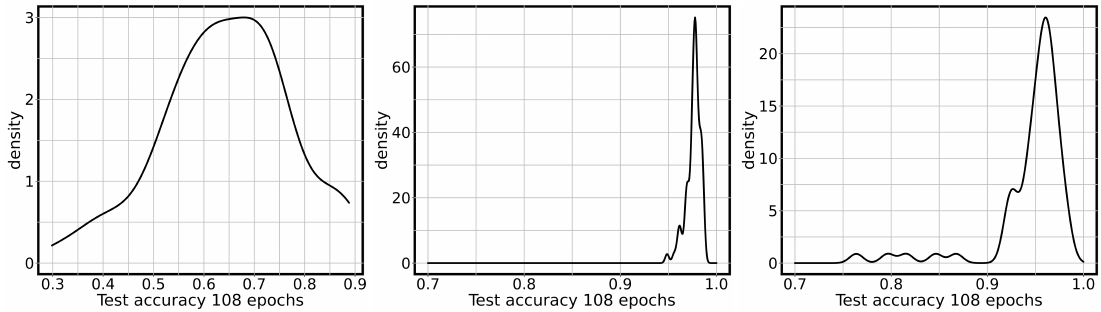
Figure 3. PDF of fitness after 36 epochs of training. From left to right are results using Sentinel-1, Sentinel-2 and both sensors as input.